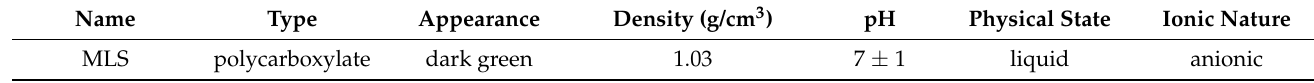
Table 3. Technical specifications of the